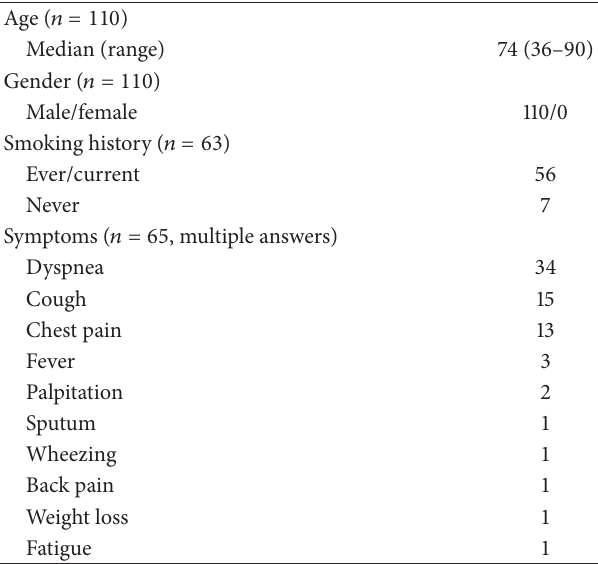
Table 1: Patient